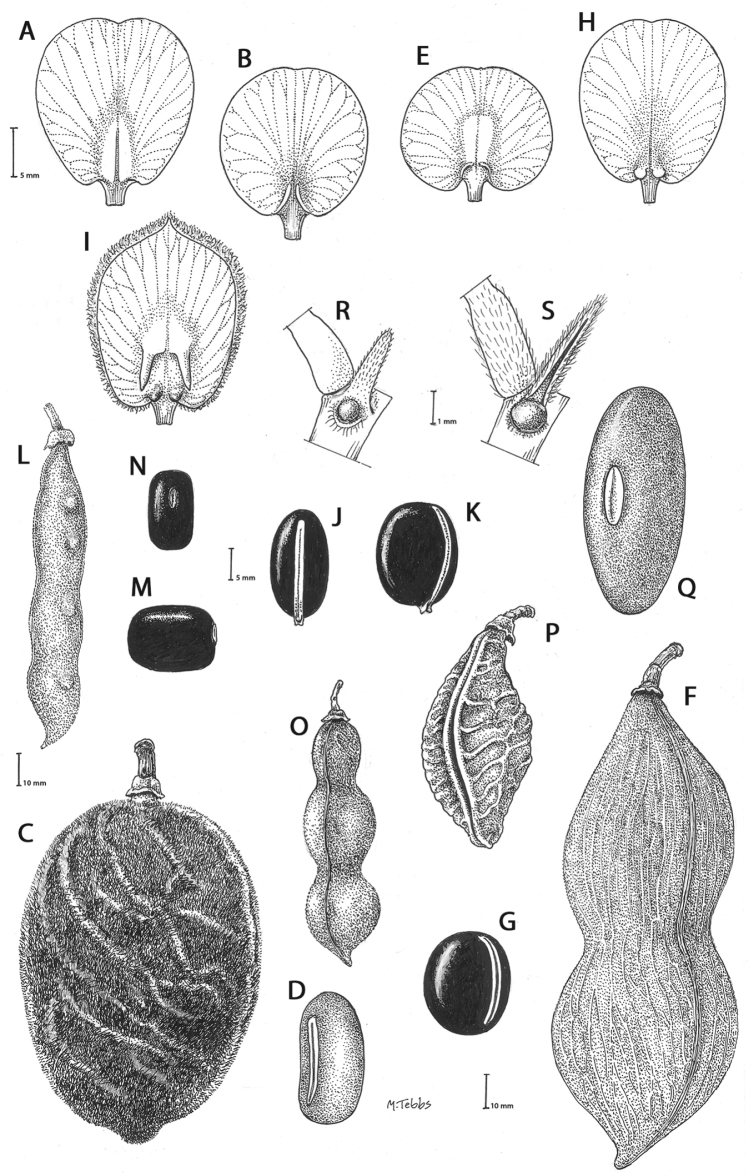
Distinctive morphological characters in Tribe Wisterieae. AEndosamararacemosa standard petal inner surface BPadbruggeadasyphylla standard petal inner surface CPadbruggeadasyphylla pod DPadbruggeadasyphylla seed lateral view EAustrocalleryaaustralis standard petal inner surface FAustrocalleryapilipes pod GAustrocalleryapilipes seed lateral view HPadbruggeafilipes standard petal IAfgekiasericea standard petal inner surface JAfgekiasericea seed lateral view KAfgekiasericea seed angled lateral view LCalleryanitida pod MCalleryanitida seed ventral view NCalleryanitida seed polar view OCalleryacinerea pod PWhitfordiodendronnieuwenhuisii pod QWhitfordiodendronerianthum seed RWisteriopsiseurybotrya gibbosity SWisteriopsischampionii gibbosity A from Luang Vanpruk 188 B from Scortechini 429 C, D from Lamb 395/91 E from L.J.Brass 32129 F, G from B.Gray 04319 H from Maung Po Khant 15326 I from C. Chermsirivathana 996 J, K from Mrs Collins 104/9 L–N from Theophilus SampsonO from G.Forrest 19279 P from J.P.Mogea 4182 Q from photo Y.Sirichamorn s.n..R from J. & M.S.Clemens 3637 S from Shiu Ying Hu 10476. See Appendix 1 for voucher details. Drawn by Margaret Tebbs.